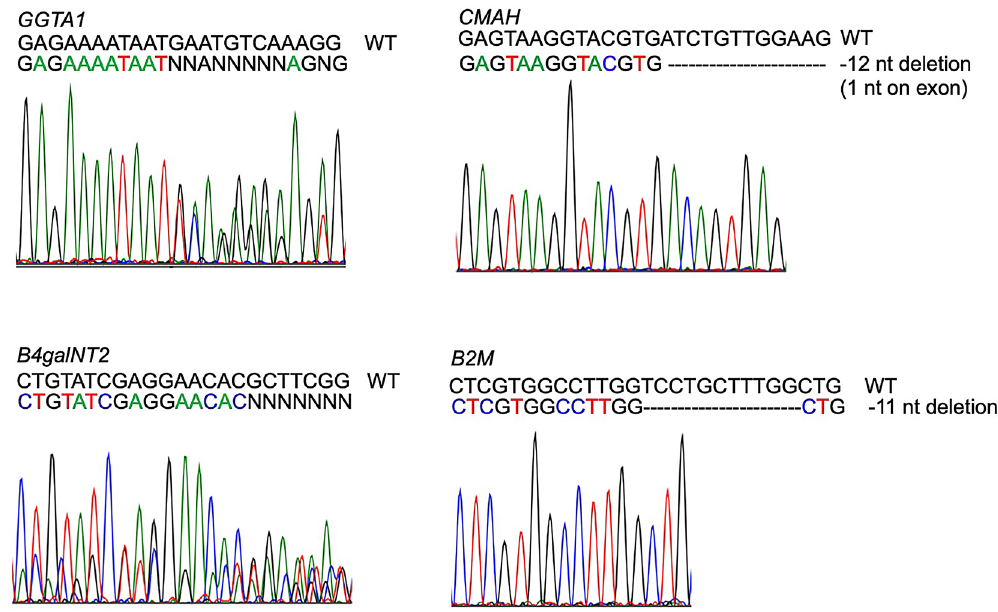
Figure 3. Genotype of GM ipLDEC. Each gRNA targeted region was amplified by PCR. Sanger sequencing revealed mutations in GGTA1 , CMAH , β4galNT2 , and B2M